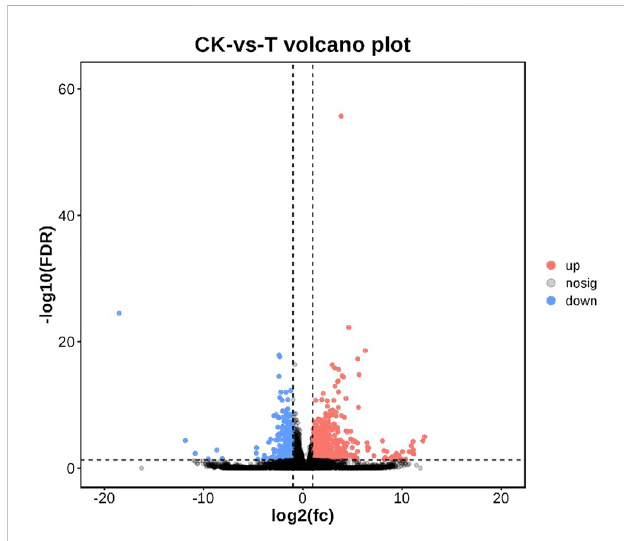
Volcano plot of differentially expressed genes. Up-regulated genes were showed as red dots, down-regulated genes were showed as blue dots, and no differentially expressed genes were shown as black